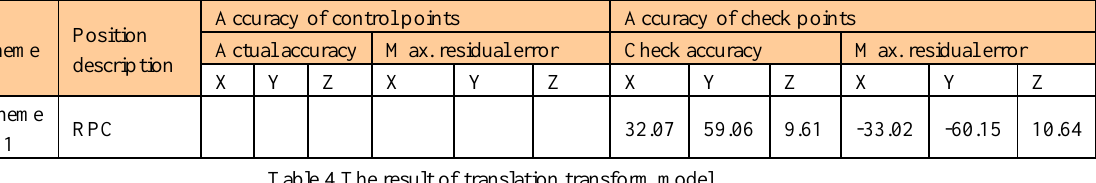
Table 4 The result of translation transform model